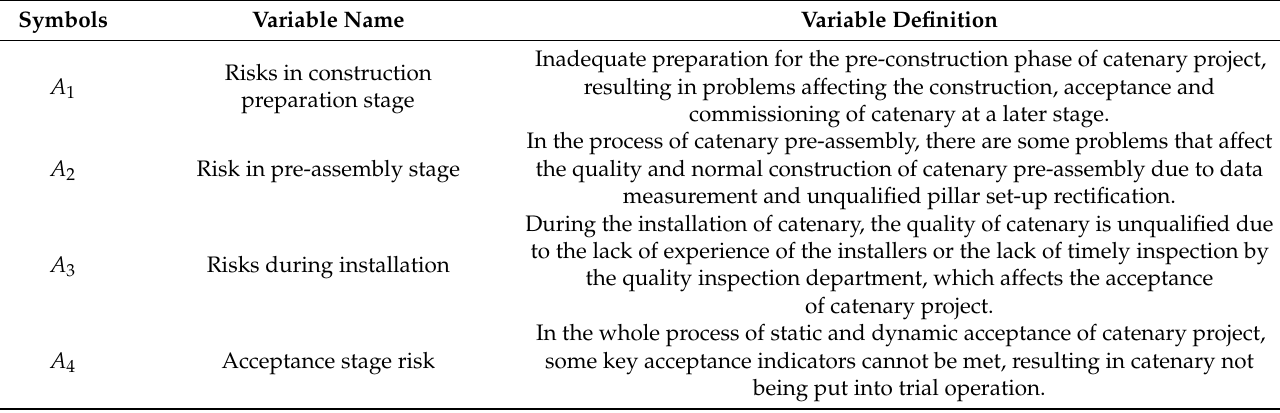
Table 3. Risk stage division of catenary construction.